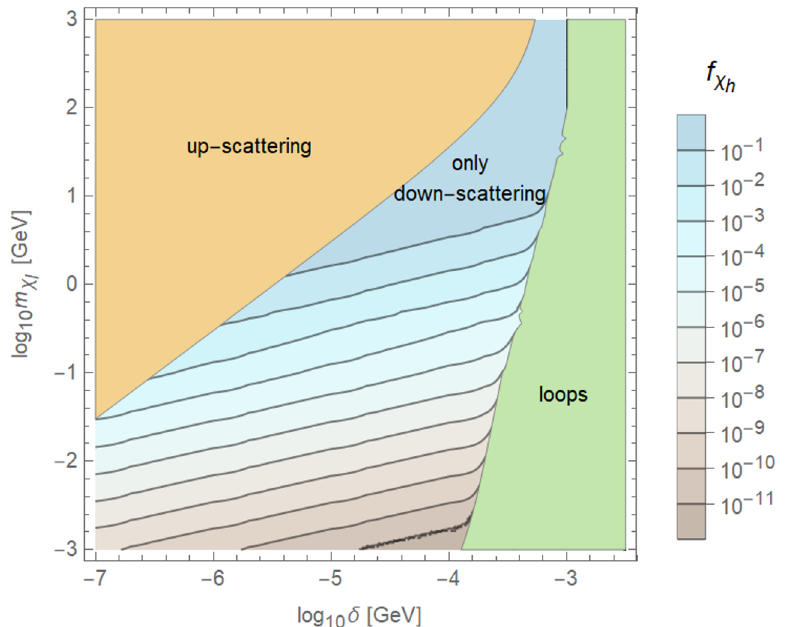
JHEP04(2022)060 Figure 8 . In the upper left region, up-scatterings are accessible (the kinematic boundary for heavy DM depends on the target nucleus, with improved reach for heavier nuclei; we have assumed A=207 (lead) to illustrate the largest plausible region). The cyan-brown region corresponds to the parameter space where down-scatterings are the only tree-level process that can occur. In this region, we show the contours of the relative abundance of the excited state observed today. Lastly, in the green region decays have heavily depleted the excited state and only loop-level elastic scatterings are expected when the Majorana masses obey m = m η ξ